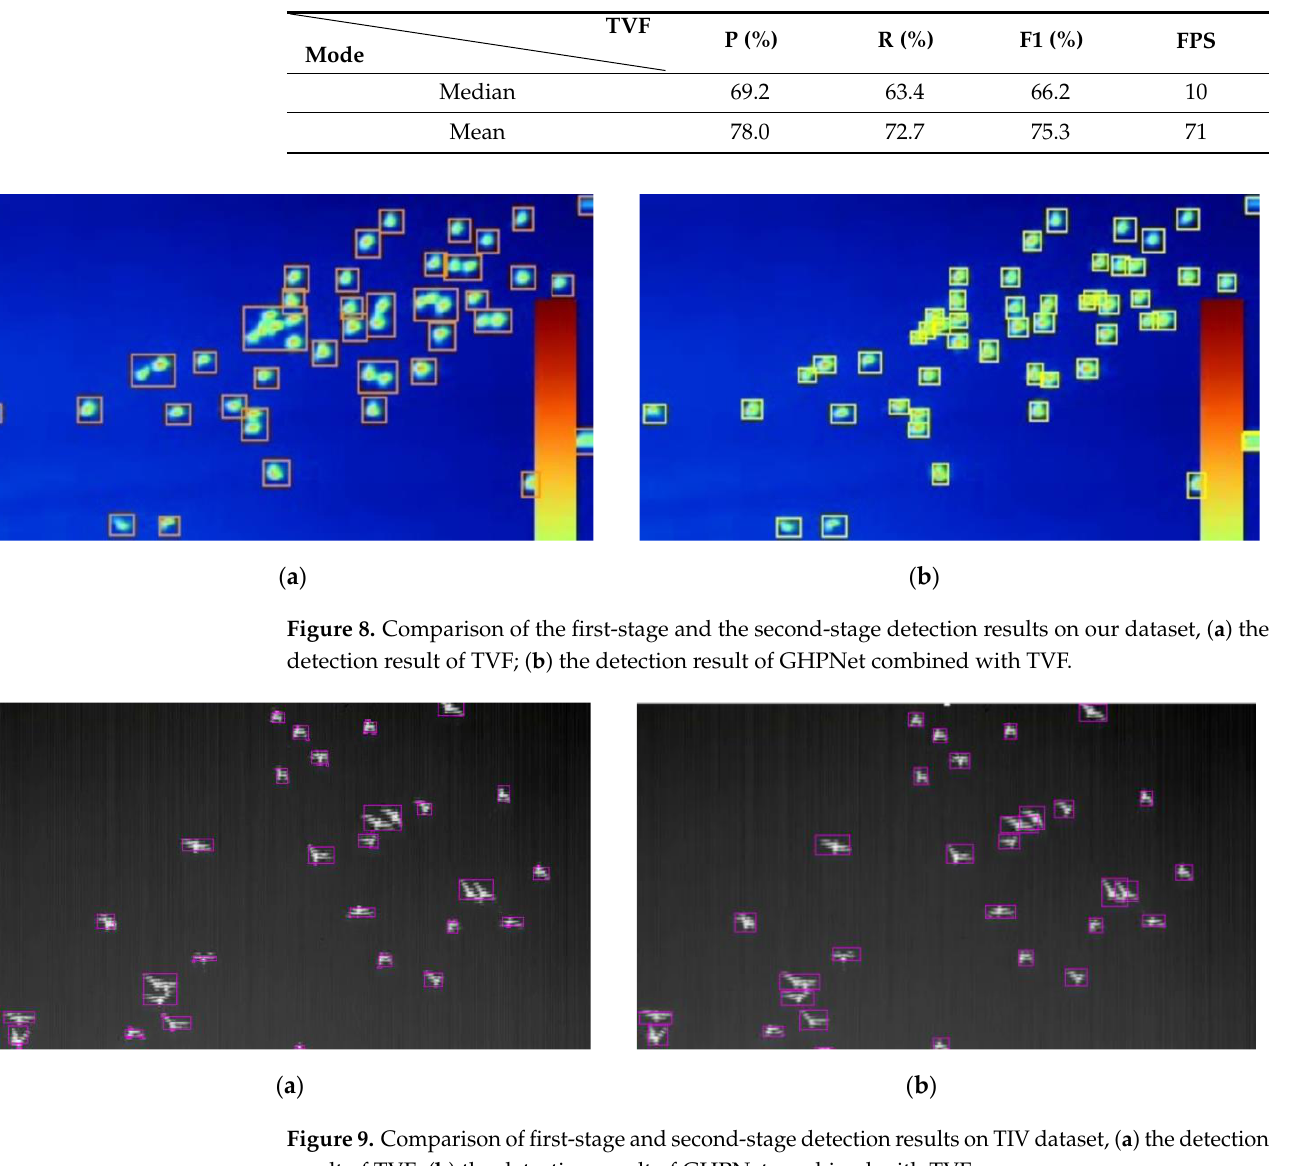
Table 5. Comparison detection results of median and mean mode used in TVF on our dataset.